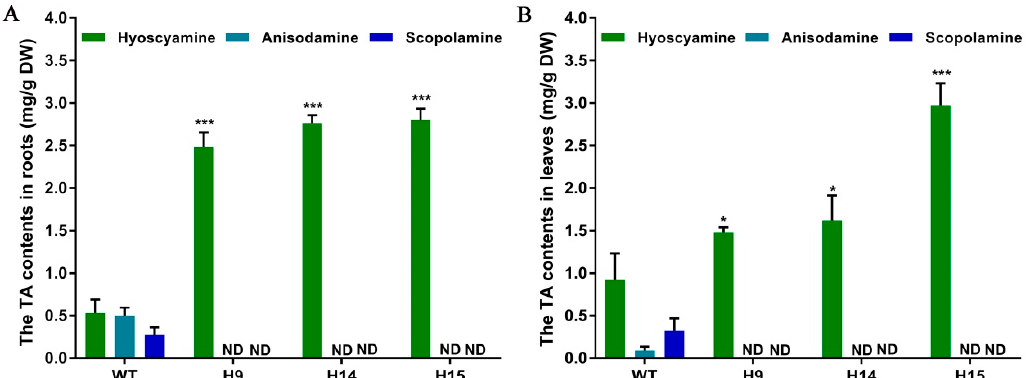
Figure 5. The contents of tropane alkaloids in ( A ) roots and ( B ) leaves of Atropa belladonna . WT, wild type Atropa belladonna plants; H9, H14, H15, independent transgenic plants with knockout of AbH6H . * and *** represent significant difference (given by t-test) at the levels of p < 0.05 and p < 0.001, respectively. ND, not detected.